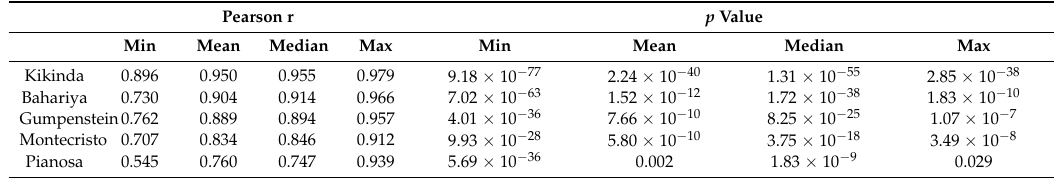
Table A1. Pearson r coefficient and p -value for ERA5 and measured data used for gap filing for DOY and gaps.